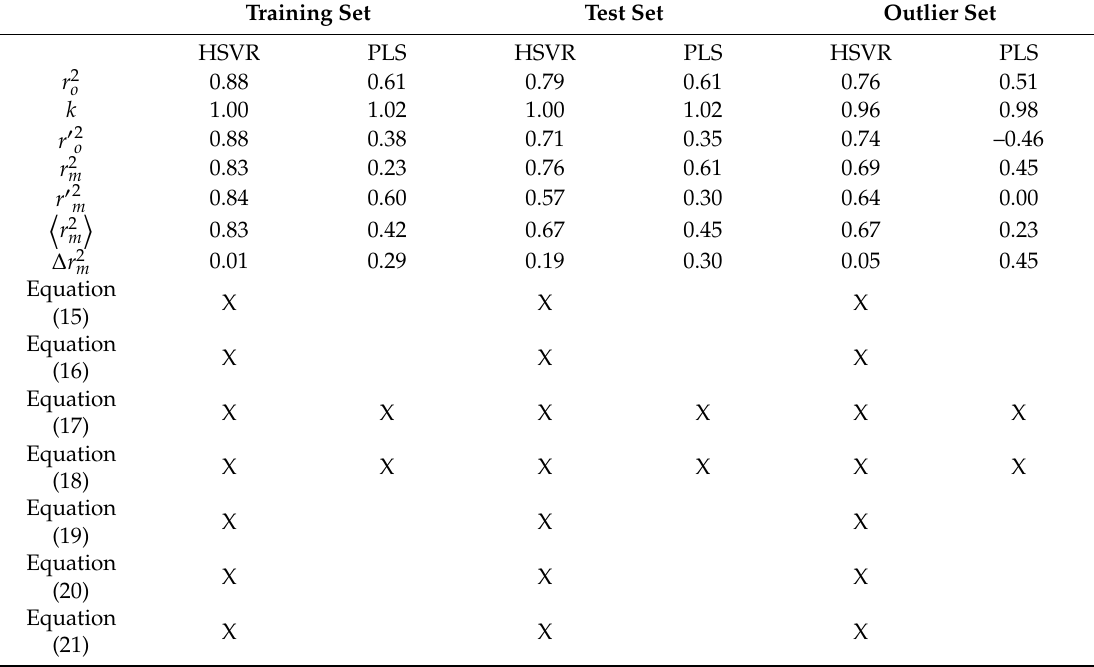
Table 5. Validation verification of HSVR and PLS based on prediction performance of the molecules in the training set, test set, and outlier